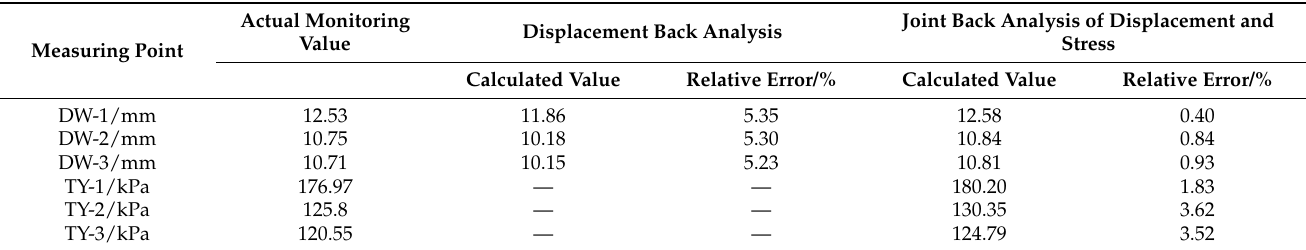
Table 8. Comparison of inversion calculation results and actual measurement